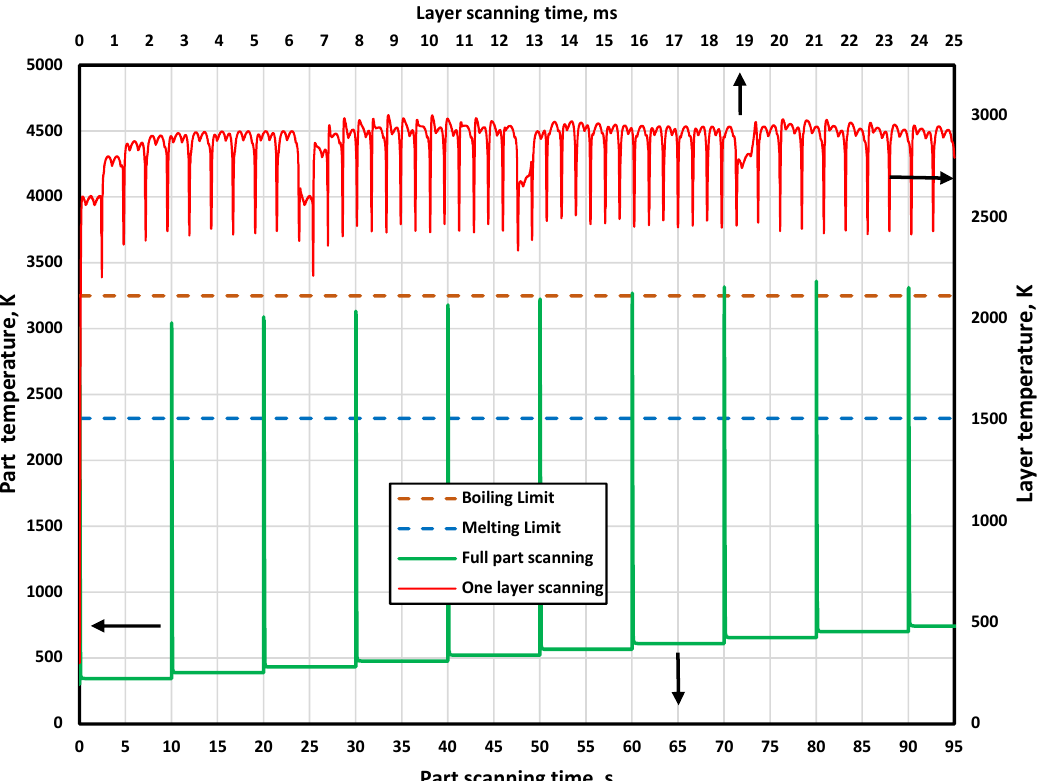
Figure 11. The temperature history for the full part and one layer printing using island scanning strategy.